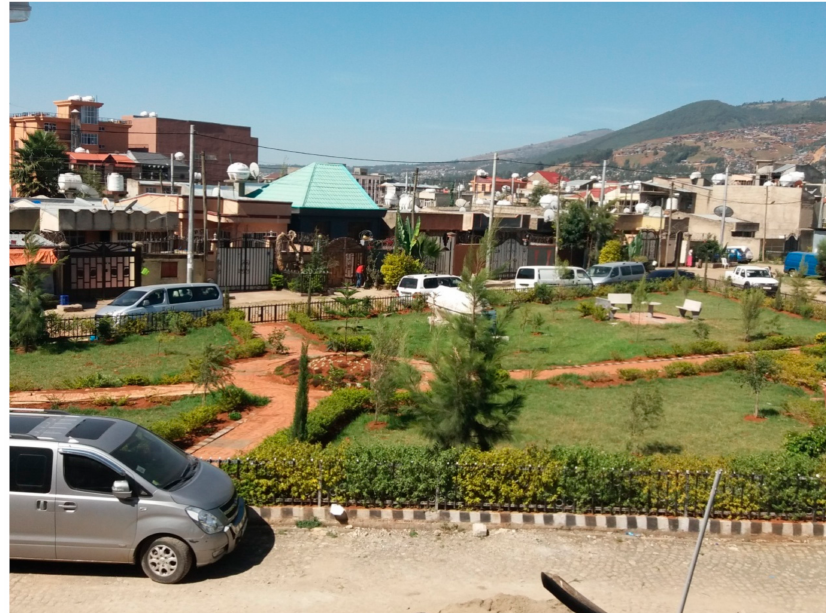
Figure 2. A newly developed neighborhood park in Kolfe-Keranyo sub-city of Addis